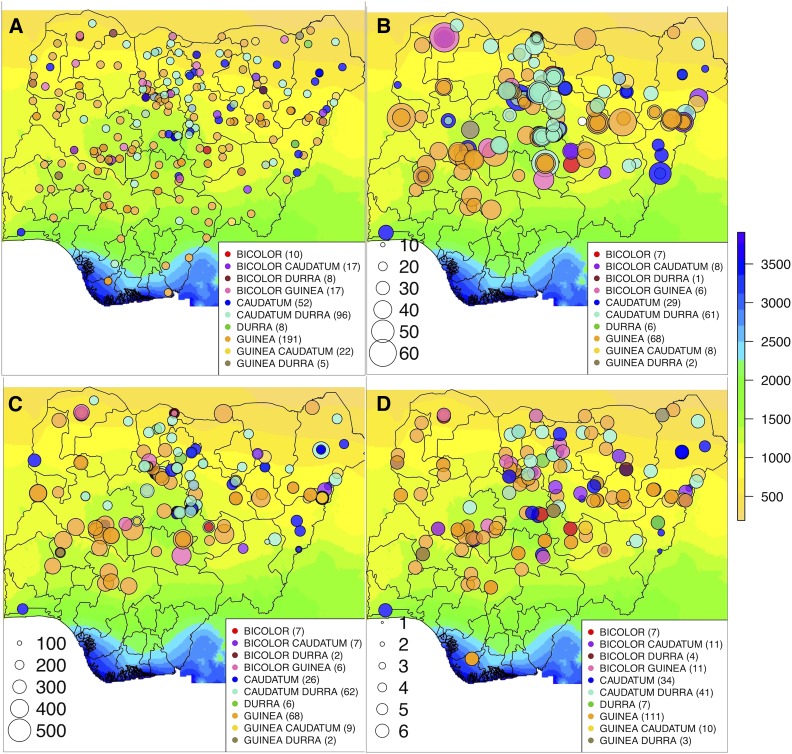
Geographic distribution of Nigerian accessions across precipitation zones. (A) Geographic distribution of georeferenced Nigerian accessions with known botanical race. (B) Panicle length variation across precipitation zones (size of circles commensurate to length of panicle in cm). (C) plant height variation across precipitation zones (size of circles commensurate to height of plant in cm). (D) flowering time variation across precipitation zones (size of circles commensurate to days until anthesis, 1 = earliest flowering and 6 = photoperiod sensitive). Background map is color-coded according to average annual precipitation (in mm).